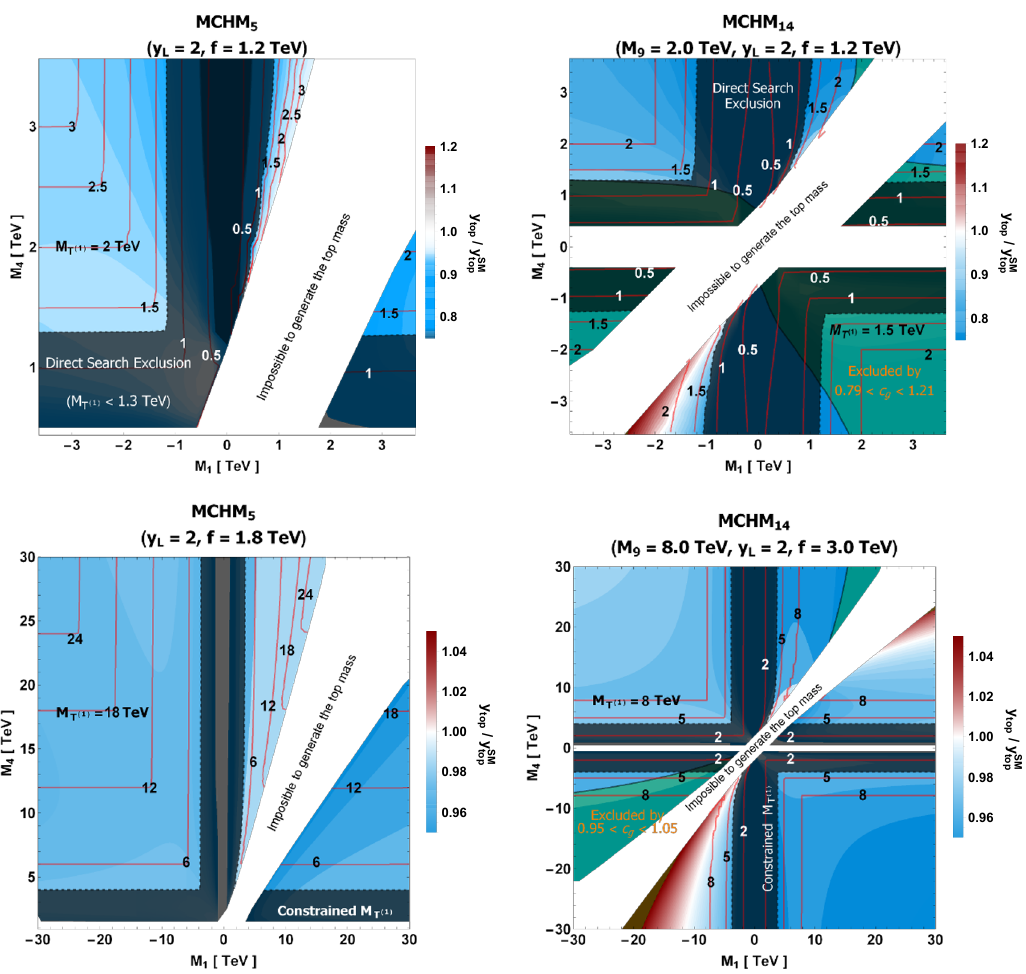
Figure 2 . Normalized value of the Yukawa coupling of the top, y top /y SM the MCHM 5 (left) and MCHM 14 (right). Top figures focus on O (1) TeV scale, bottom ones expand it to higher mass scales. Also shown are contours of constant mass of the lightest top partner, M . Overlayed regions indicate constraints: the dark one is given by direct exclusion of top T (1) partners in the top plots [9, 10], and by expected constraints in the HL-LHC in the bottom ones ( M < 4 TeV) [48]; the green region is constrained by c g measurements [42] in the top plot and T (1) by the c g expected constraints [48] in the bottom one. In the white region, the top mass cannot be reached without violating